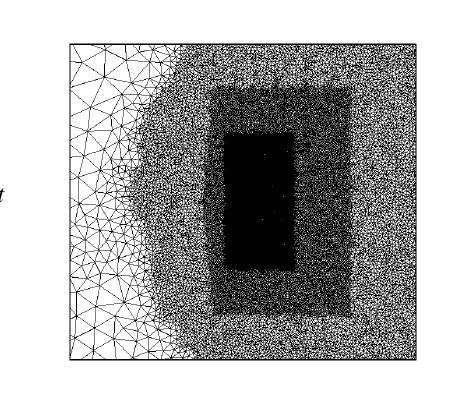
Fig. 2. Detail of the mesh.